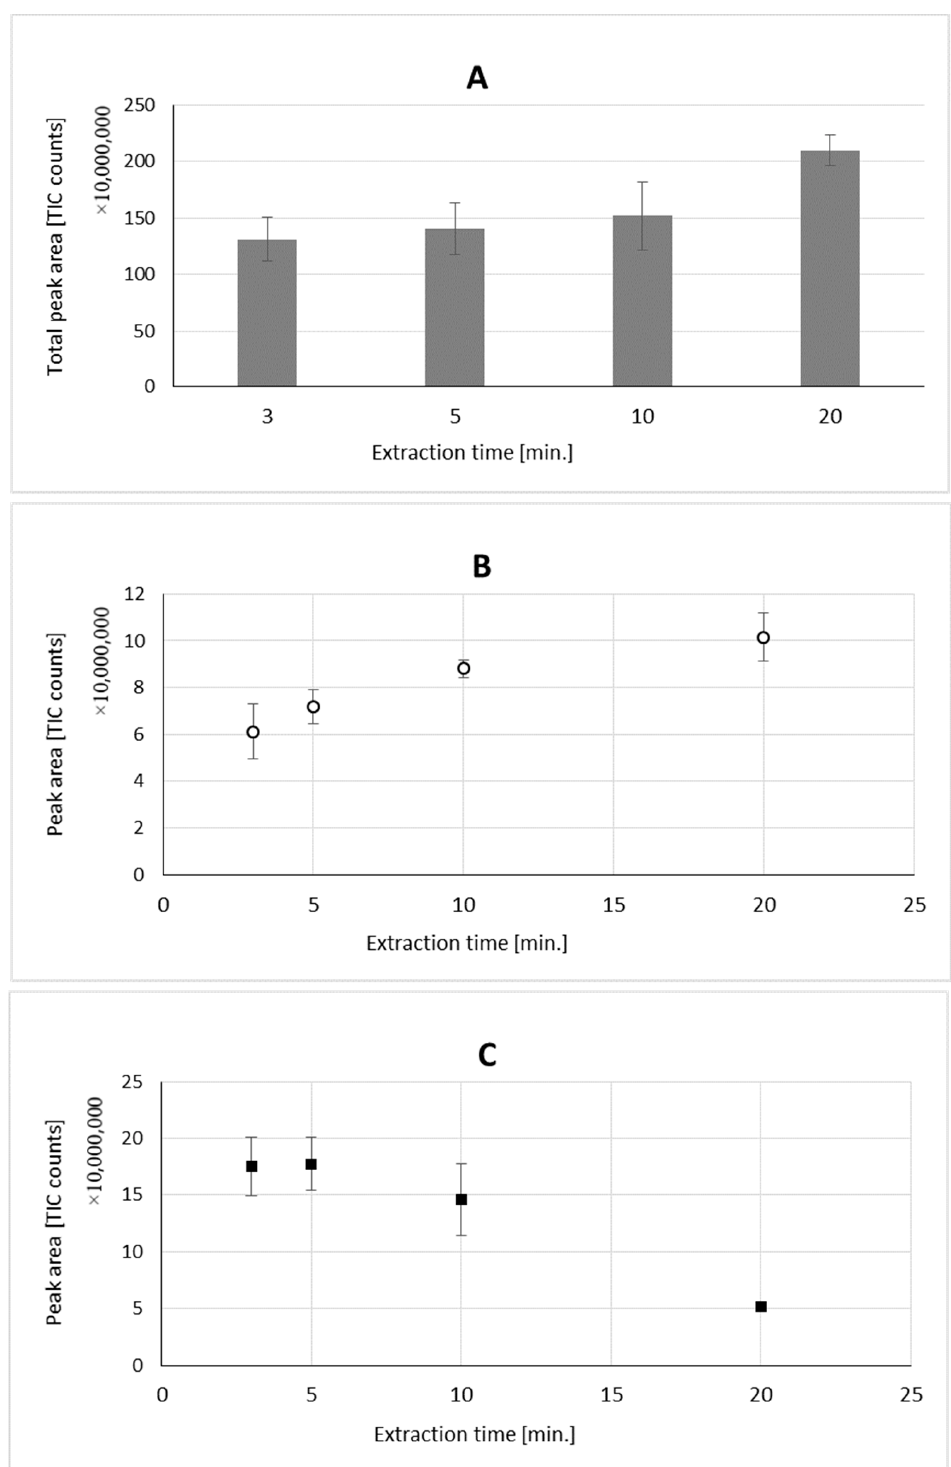
Figure 4. Total peak area of terpenes isolated after 3, 5, 10, and 20 min extraction times ( A ); different extraction behavior of two compounds: camphene ( B ) and γ -terpinene ( C ).